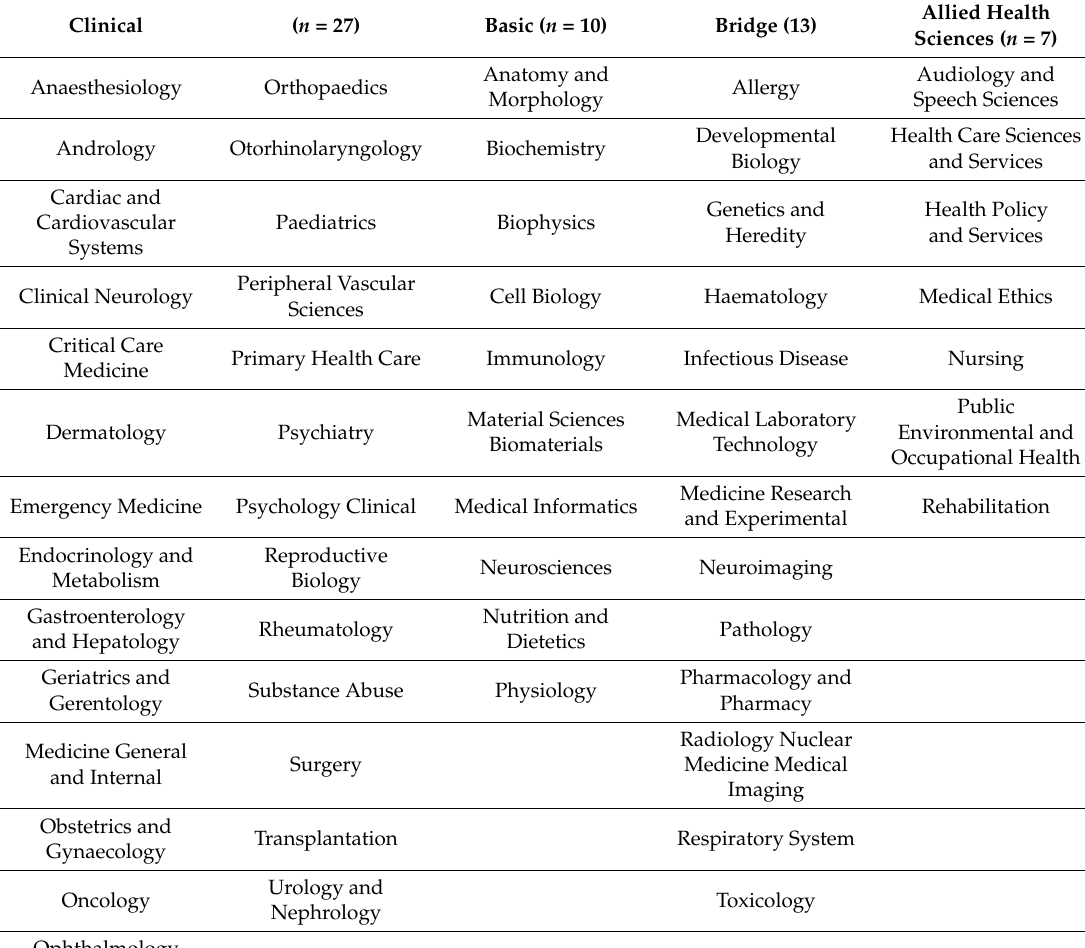
Table 1. Web of Science Research Areas by